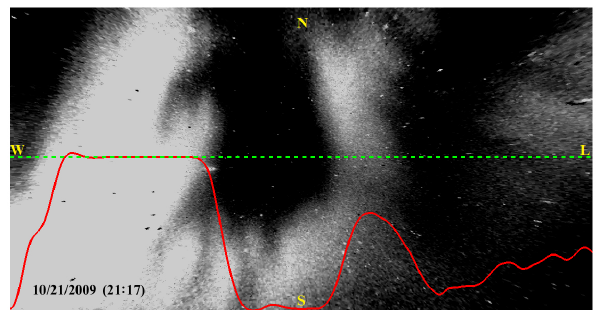
Figure 2. Example of keogram construction from airglow (OI 6300Å)